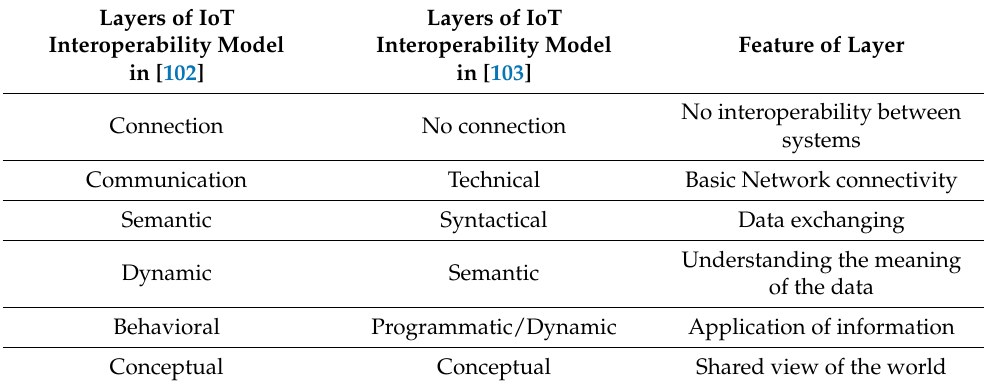
Table 7. Interoperability layers and